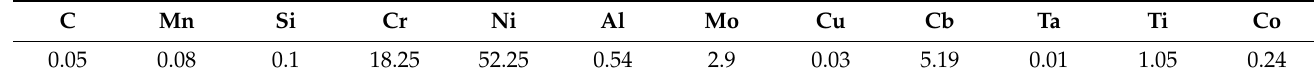
Table 2. Chemical composition (wt.%) of the 718 alloy.